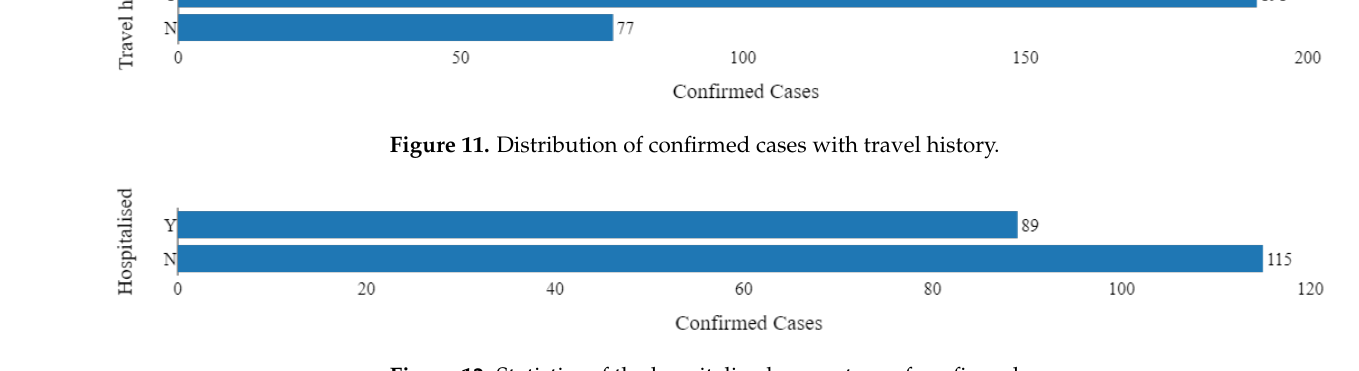
Figure 12. Statistics of the hospitalized percentage of confirmed cases.